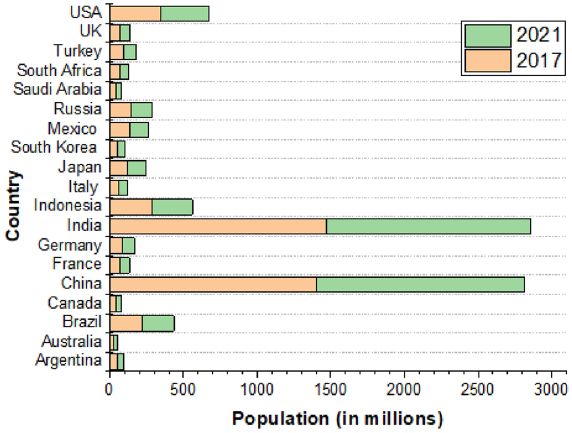
Figure 1. Population growth in G20 countries between 2021 and 2027 (in millions) 13